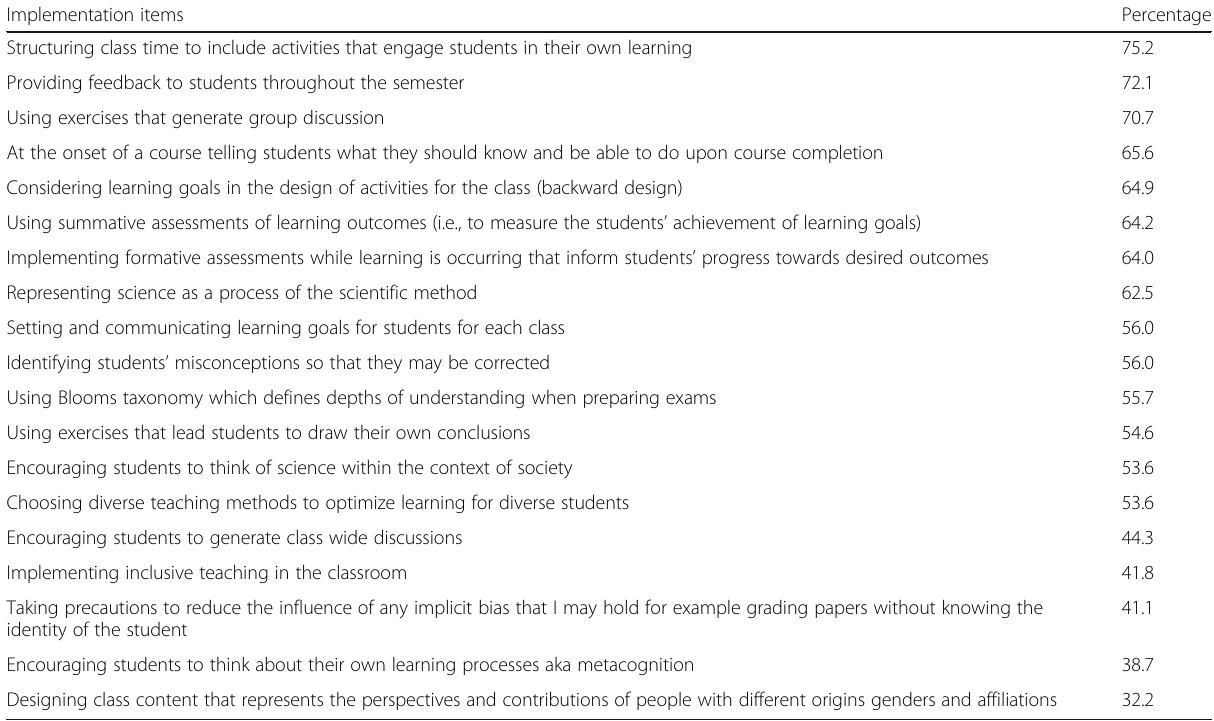
Table 4 Percentage of faculty reporting having implemented each EBT practice in our implementation measure Implementation